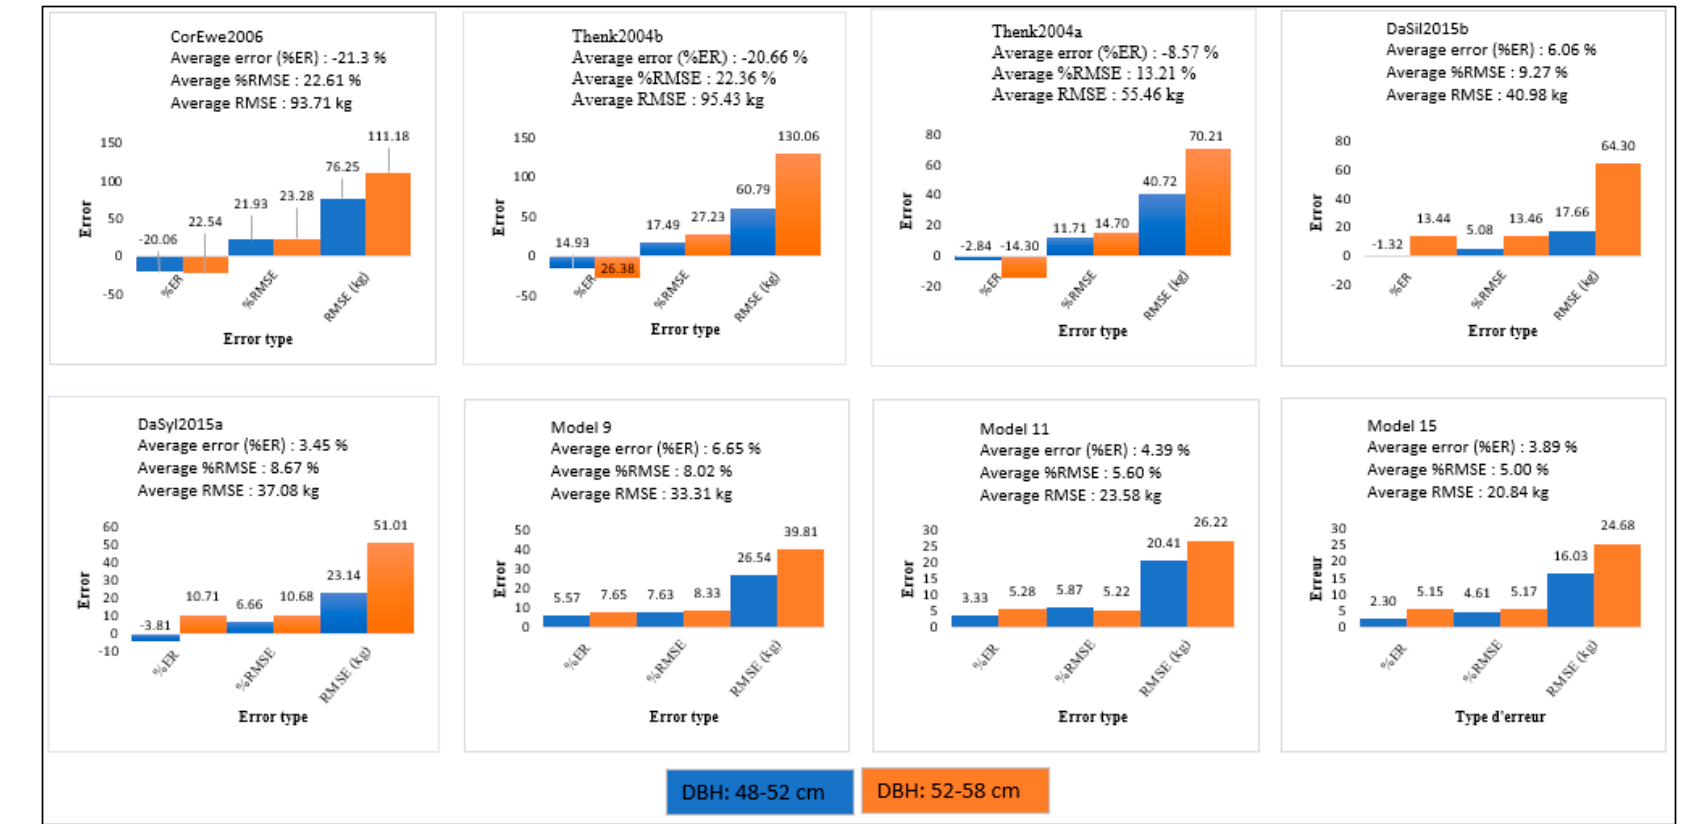
Figure 6. Errors in the allometric models when considering the two DBH classes (48 – 52 cm, 52 – 58 cm).